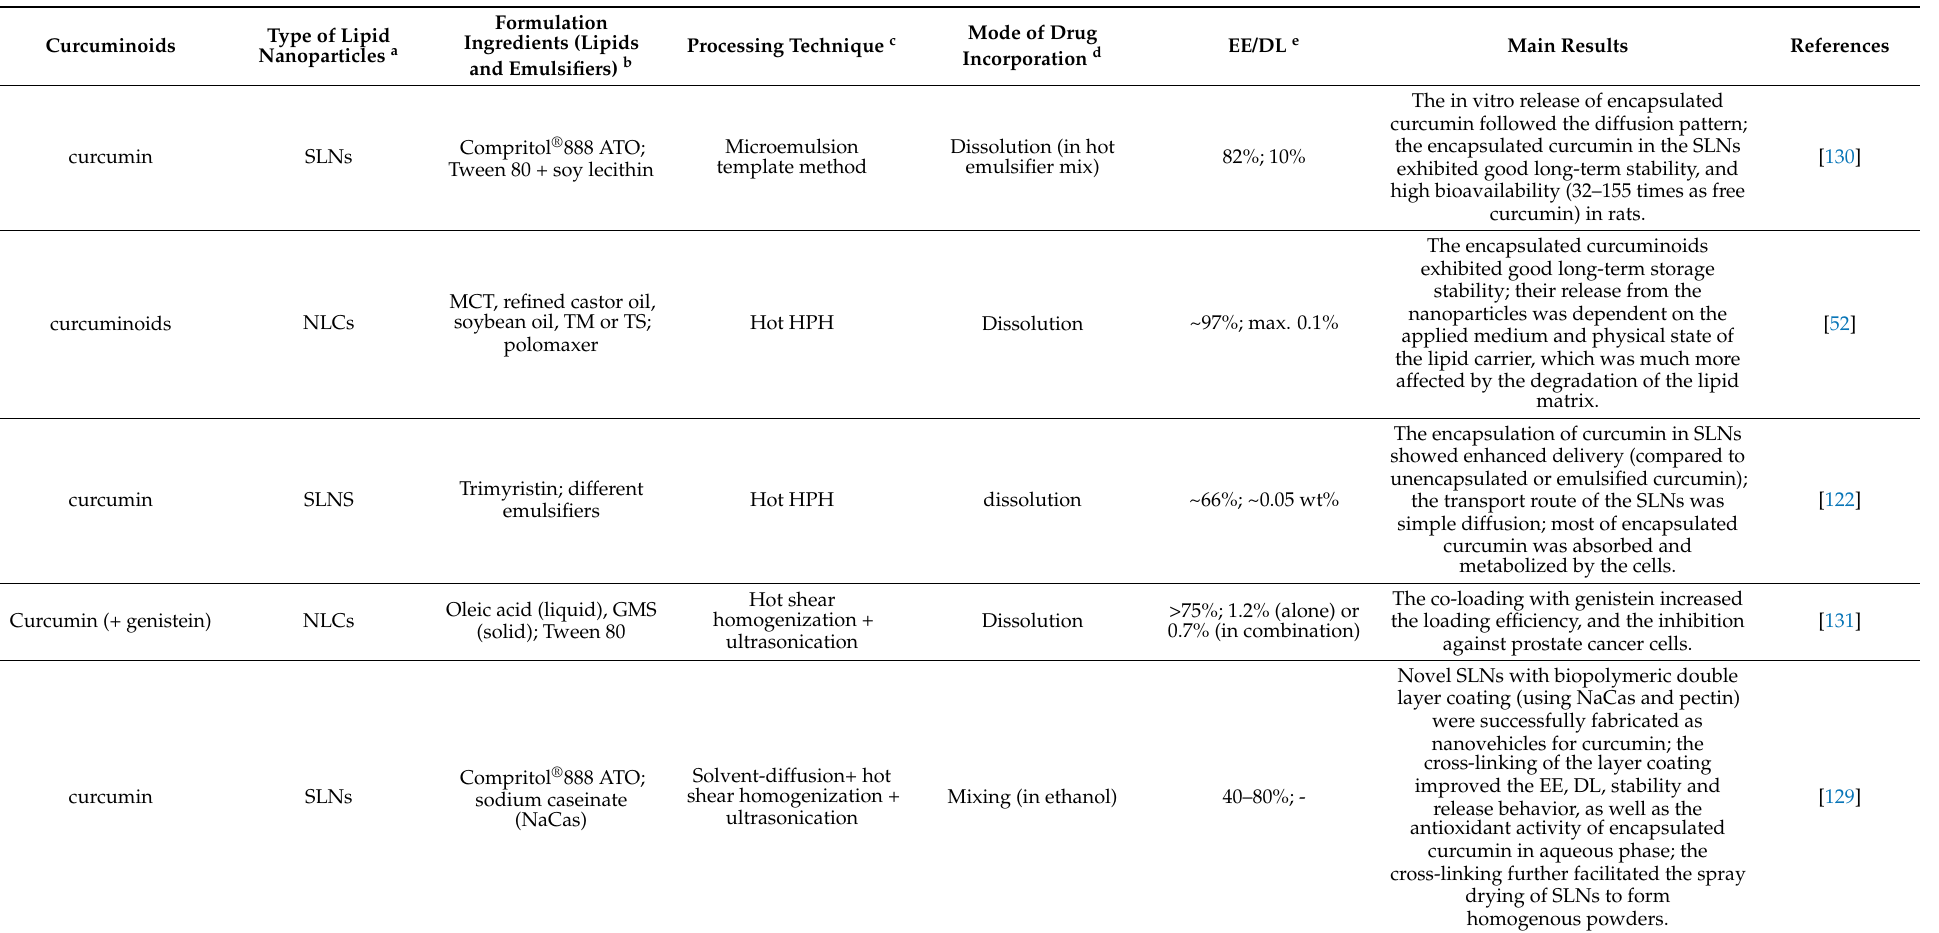
Table 2. A summary of some representative works addressing the fabrication and characterization of SLNs and/or NLCs as food-grade nanovehicles for curcuminoids or turmeric